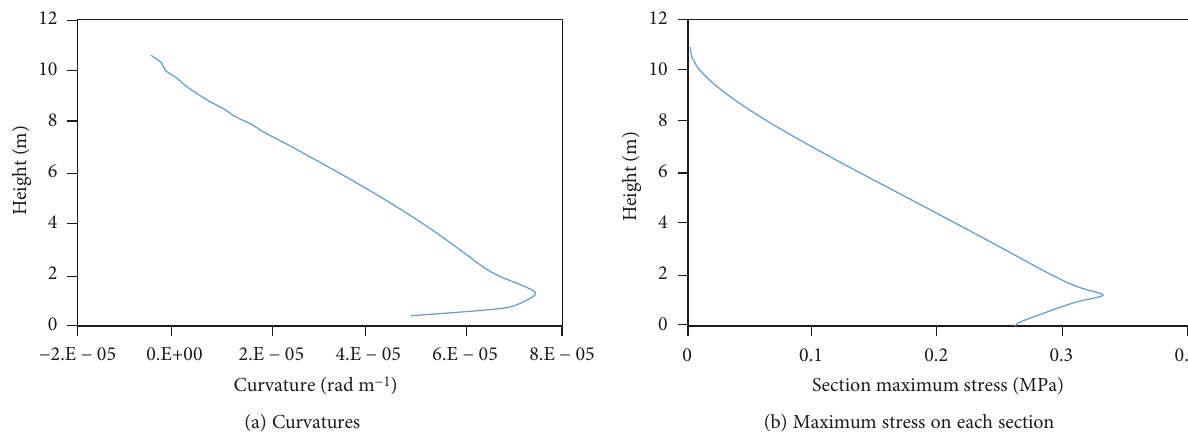
Figure 7: Curvatures and section maximum stresses along the height of an unreinforced stem subjected to a wind load: (a) curvatures and (b) maximum stress on each section.